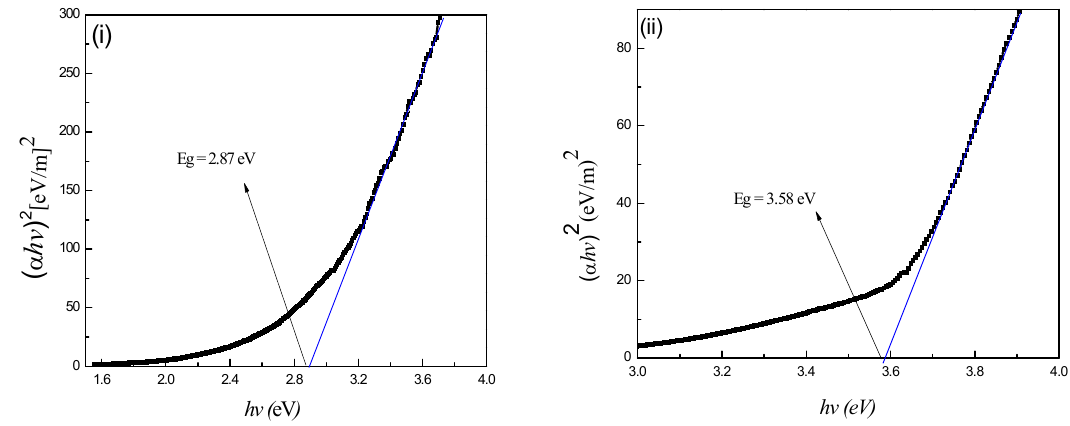
Figure 6. Optical band gap energy for the as prepared ( i ) CdSe and ( ii ) ZnSe nanoparticle.